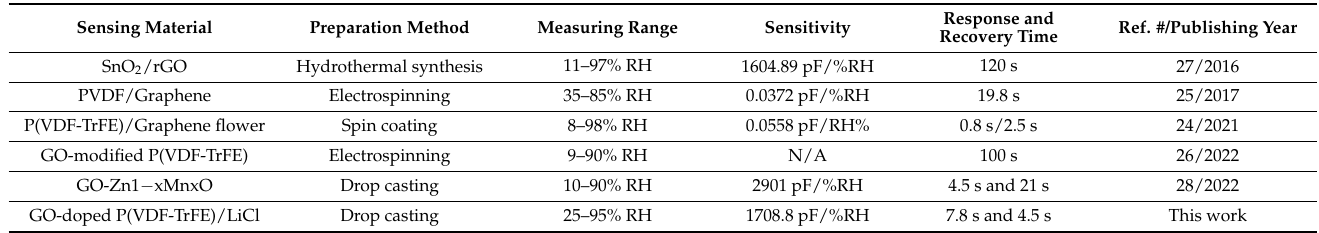
Table 2. Humidity performance of the GO-doped P(VDF-TrFE)/LiCl-composite sensor compared with that of sensors from previous studies.